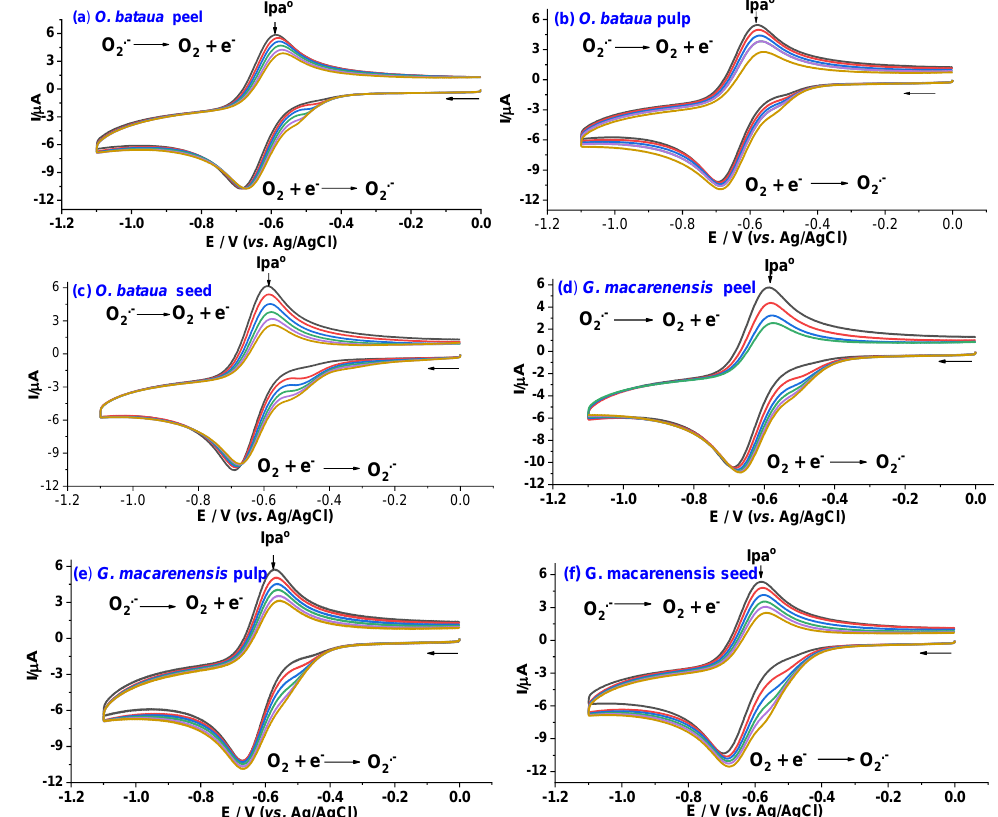
Figure 1. Voltammograms depicting the formation of the radical anion O 2 •− on the surface of a glassy carbon electrode after successively increasing the concentration of the ethanolic extract of ( a ) O. bataua peel, ( b ) O. bataua pulp, ( c ) O. bataua seed, ( d ) G. macarenensis peel, ( e ) G. macarenensis pulp, and ( f ) G. macarenensis seed, in a solution of DMS+ Bu 4 NPF 6 0.05 M. Scan rate, 0.1 V/s. Table 2. Antioxidant properties of O. bataua and G. macarenensis determined using